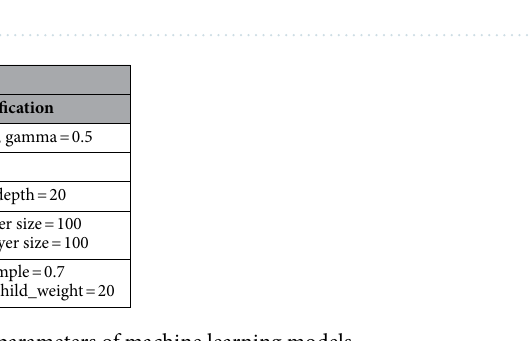
Table 3. Summary of important hyper-parameters of machine learning